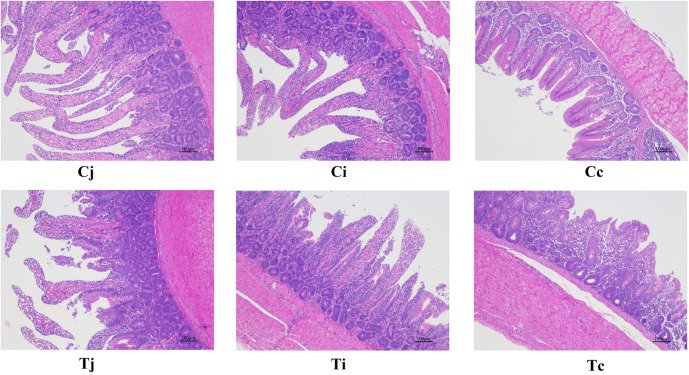
Tissue sections (100×) of intestinal mucosa in jejunum, ileum, and cecum in ducks with/without HS (n = 5 for each group). Cj, Ci, and Cc stand for the jejunum, ileum, and cecum of control. Tj, Ti, and Tc stand for the jejunum, ileum, and cecum of the thermal treated group, respectively. This also applies to the following figures.